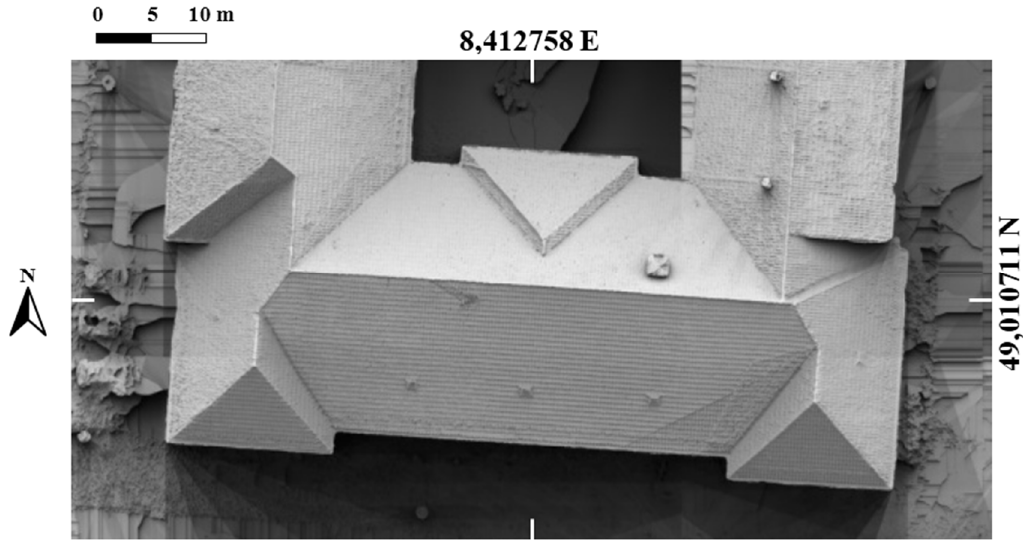
Figure 7. DSM derived from high resolution UAV images: pixel size 0.02 m, flying height approx.